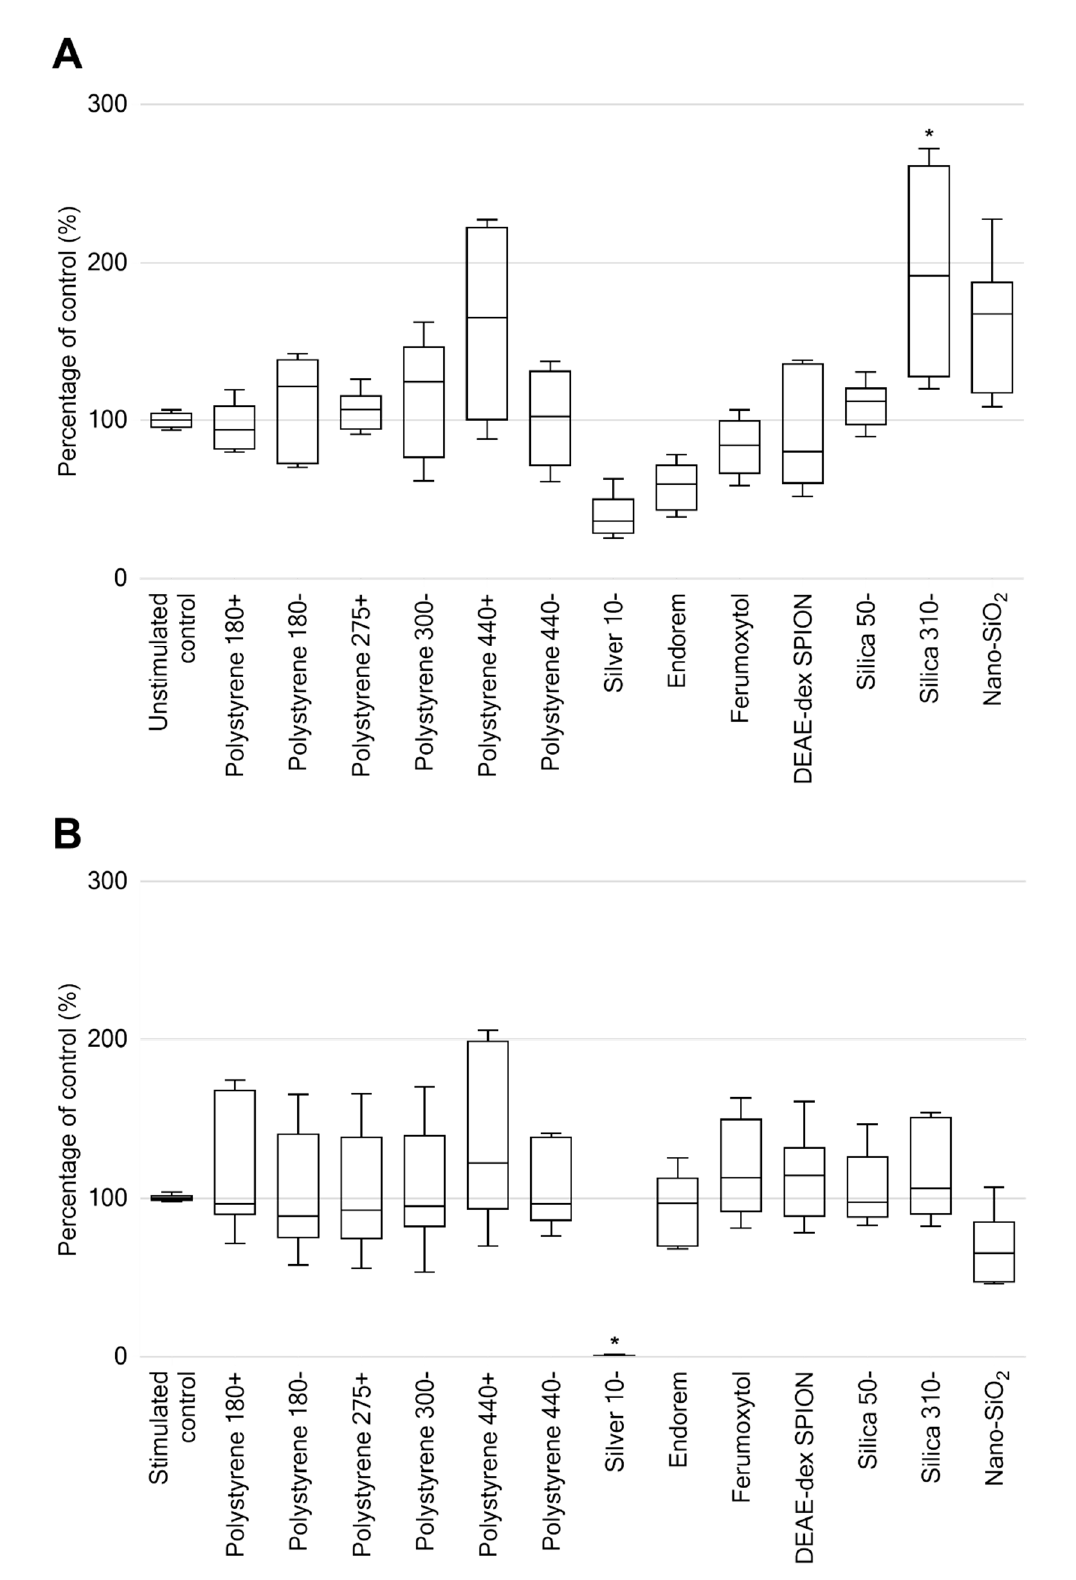
Figure 4. Proliferation of peripheral blood mononuclear cells, as a percentage of controls, following treatment with ( A ) stated nanomaterials. ( B ) Combined treatment with PHA and stated nanomaterials. Data displayed as box and whisker plots showing average of six technical replicates, maximum, and minimum ± standard deviation. * p -value < 0.05.